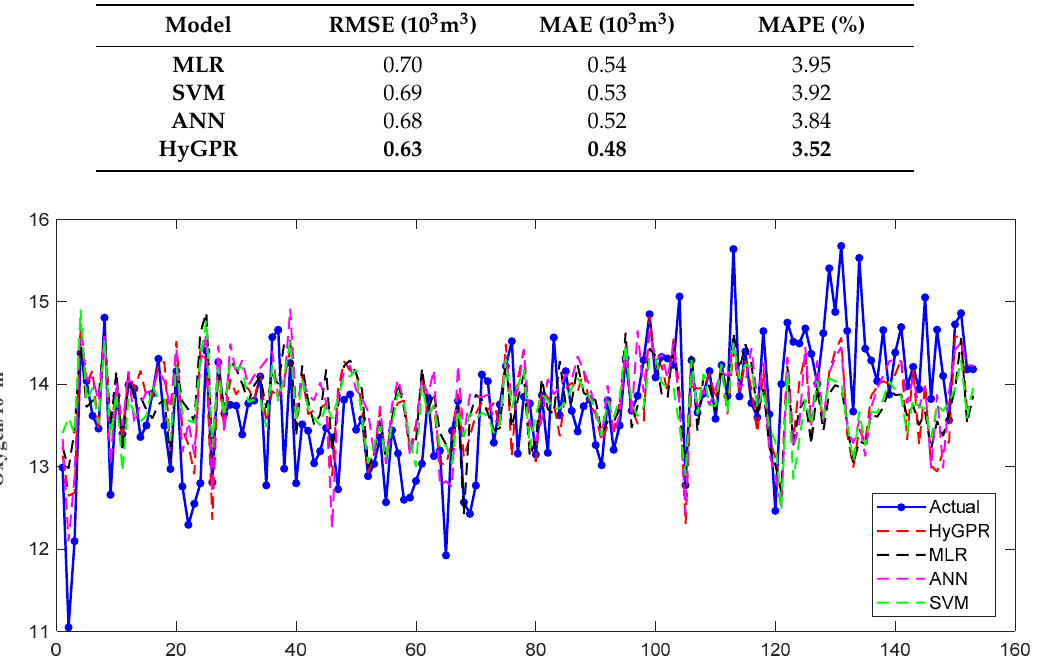
Table 3. Performance evaluation of compared models on the test set (The best metrics are highlighted in bold).